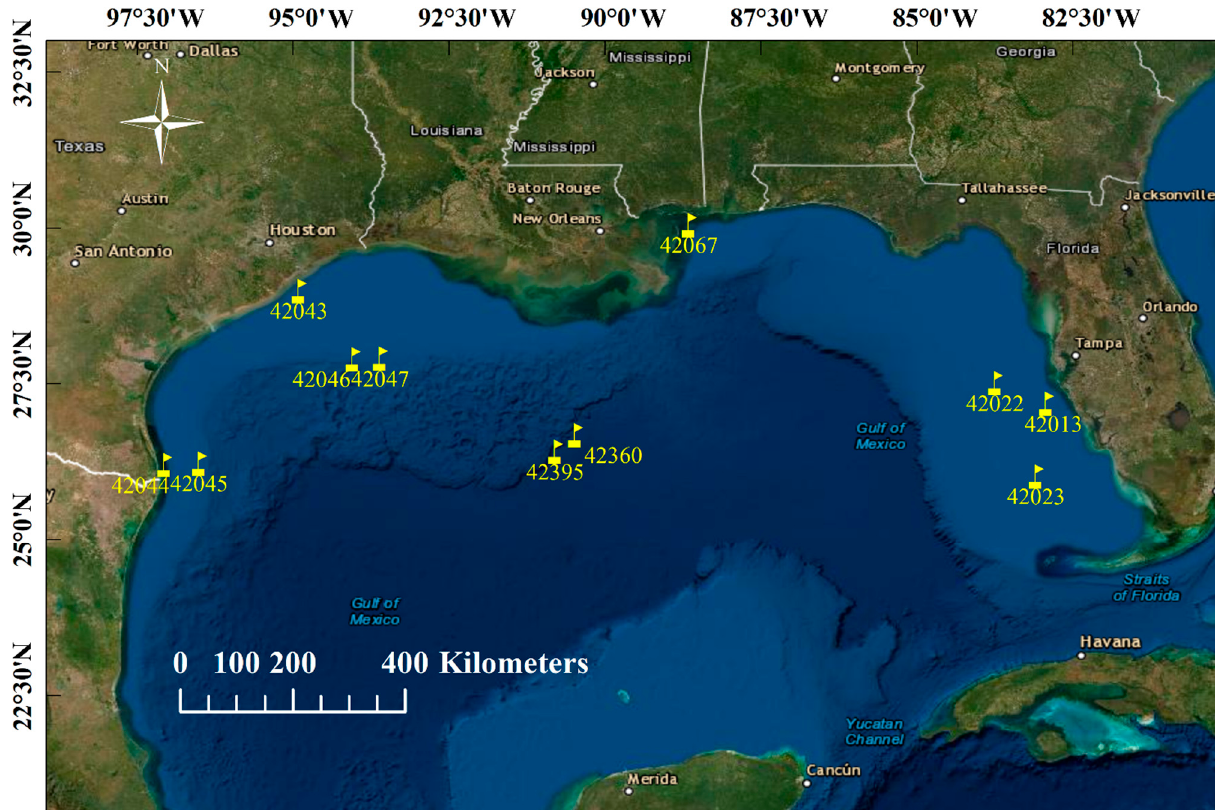
Figure 1. Locations of the NDBC buoys for training the OPEN model in this study. The yellow marks indicate the locations of NDBC buoy data.